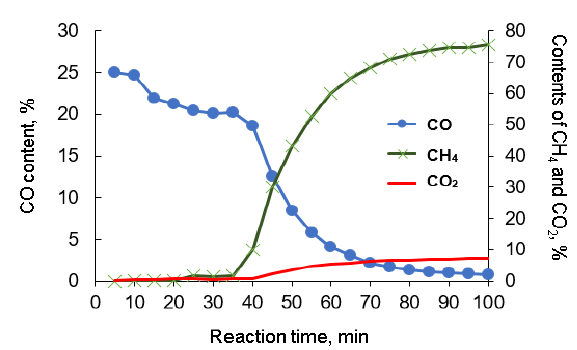
Fig. 2. CO, CH and CO contents during methanation 4 2 synthesis with the Ni/Al(N)